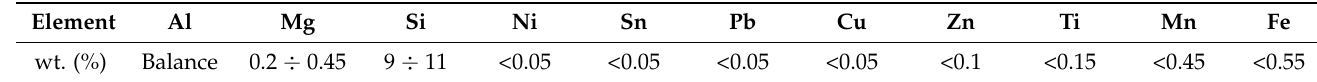
Table 1. Chemical composition of AlSi10Mg alloy